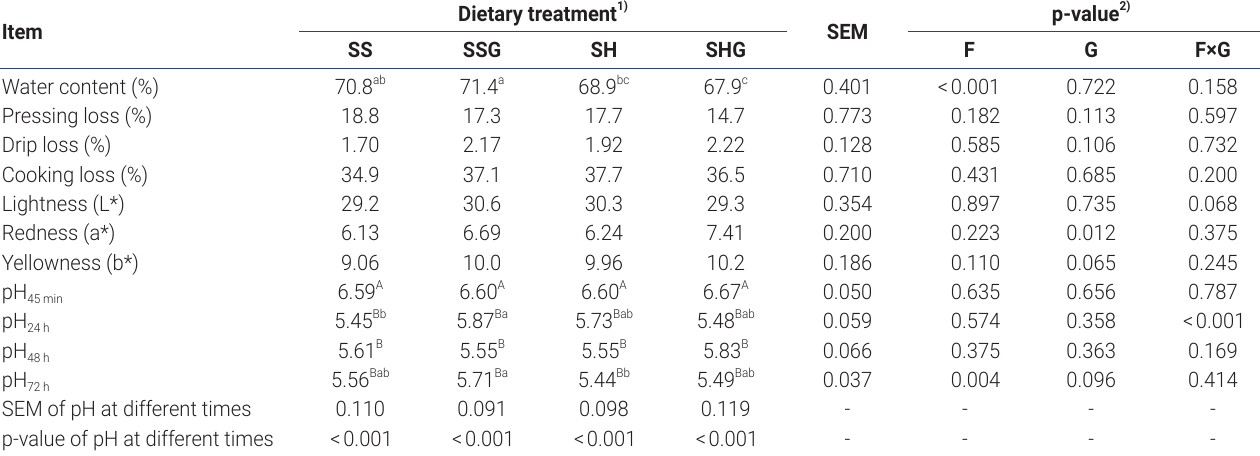
Dietary treatment 1)